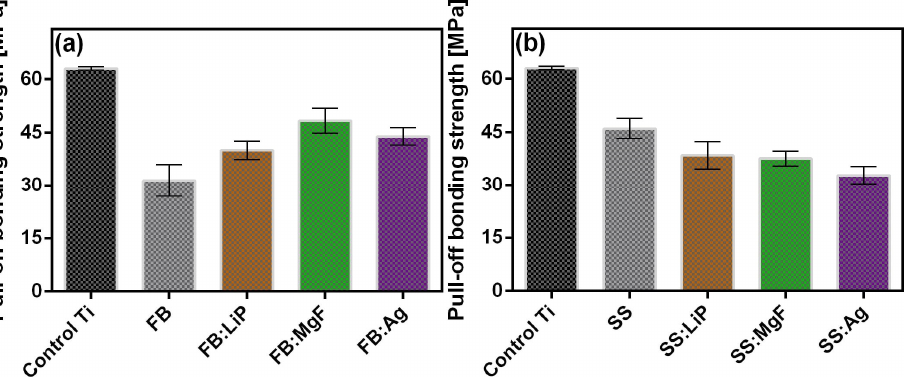
Figure 7. The adherence values at the film–Ti substrate interface for simple and doped FB ( a ) and SS ( b ) thin fi lms.